Question: Condense the content of this figure into a single sentence.
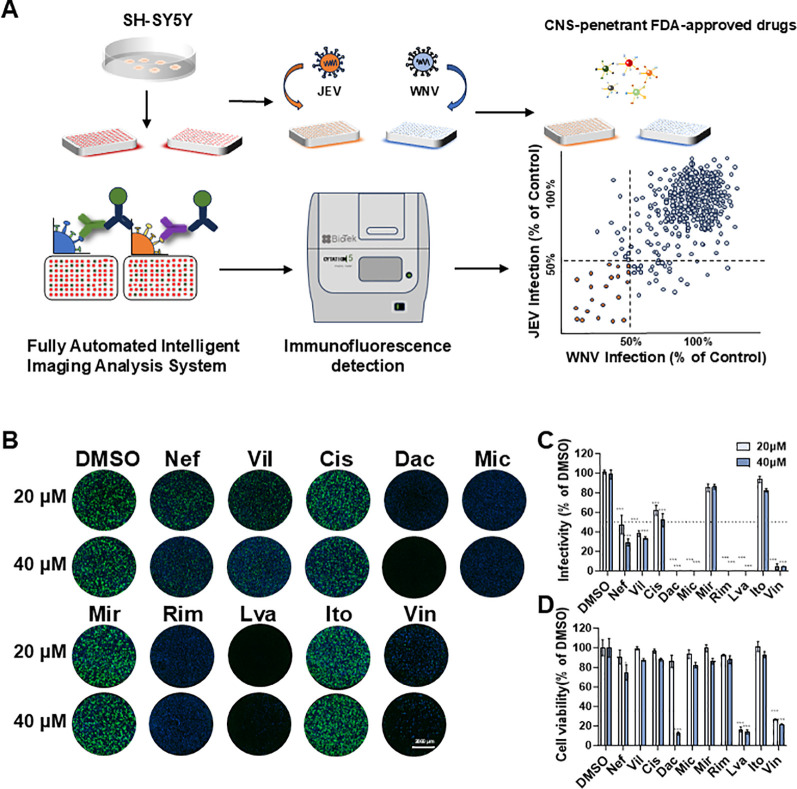
Answer: Screening of anti-WNV candidates from a BBB-penetrant FDA-approved drug library. (A) Schematic of high-throughput screening against WNV and JEV. (B, C) SH-SY5Y cells infected with WNV (MOI = 0.3) in the presence of 10 candidate compounds (20 and 40 μM) for 4 hours. (B) Representative immunofluorescence images (virus antigen, green; DAPI, blue). (C) Quantification of infected cells normalized to DMSO control. (D) Cell viability assessed by CCK-8 assay. Abbreviations: Mic, miconazole nitrate; Nef, neflamapimod; Vil, vilazodone hydrochloride; Dac, dacomitinib; Cis, cisatracurium besylate; Mir, mirtazapine; Rim, rimonabant; Lva, lvacaftor; Ito, itopride hydrochloride; Vin, vinorelbine ditartrate. Data represent the mean ± SD of three biologically independent experiments (n = 3). *P < 0.05, ***P < 0.001 vs. DMSO control.